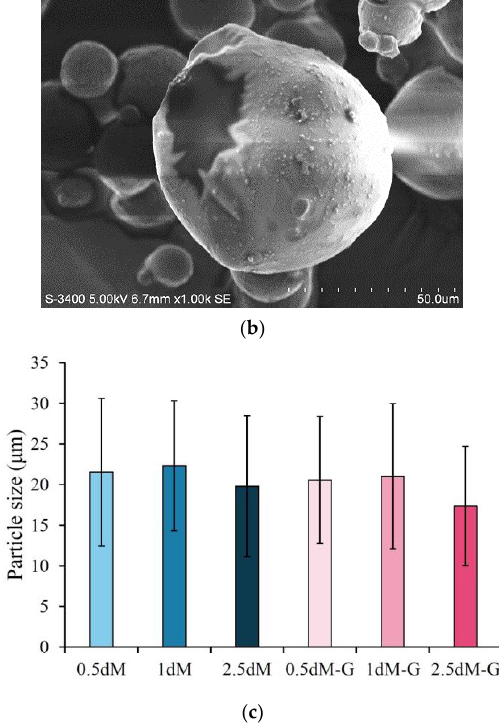
Figure 4. Morphology of unmodified microspheres and microspheres modified with different con- centrations of DAP and PC: ( a ) SEM image, ( b ) microspheres with cracks observed to further confirm that the interior is hollow, and ( c ) microsphere diameter measurement ( n = 100, p > 0.05).